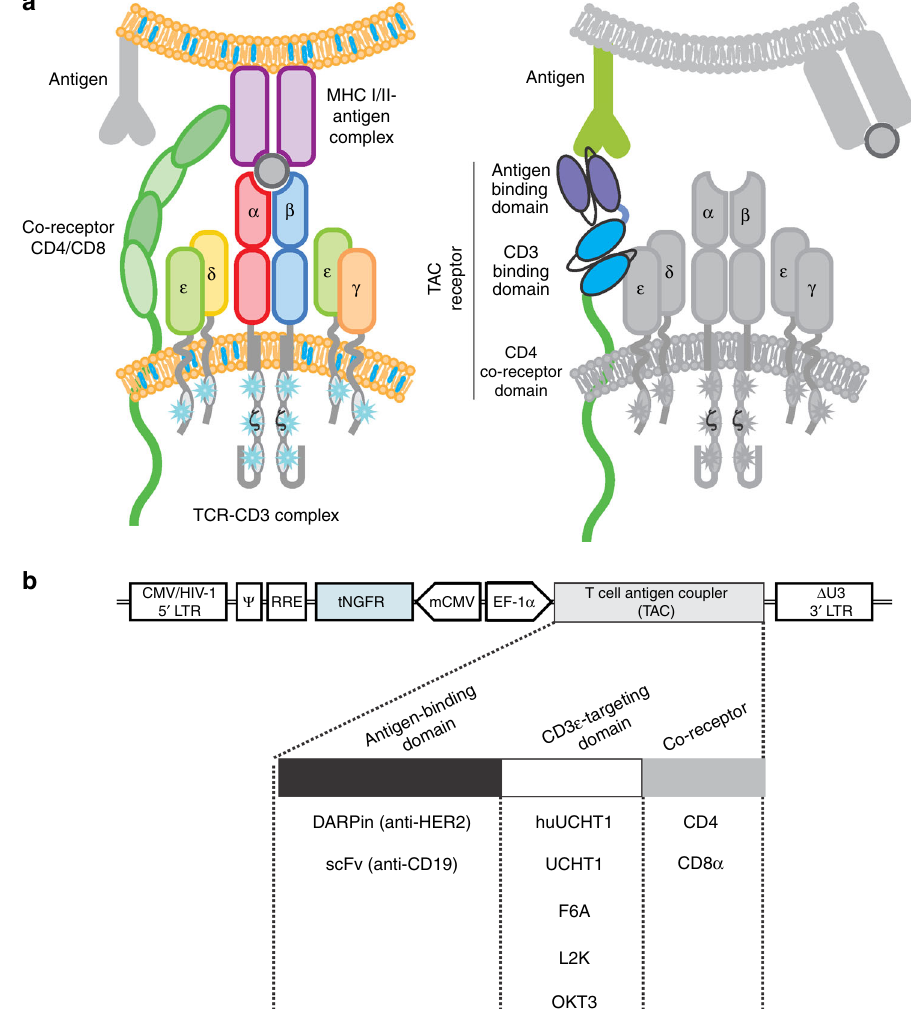
Fig. 1 TAC design mimics the TCR-CD3:co-receptor complex. a Left: Naturally occurring TCR-CD3 complex interacts directly with the antigen presented by MHC. Meanwhile, the CD8/CD4 co-receptor interacts with MHC I/II in an antigen-independent manner. Together, these interactions comprise the fi rst step in T cell activation. Right: The TAC receptor re-directs the TCR-CD3 complex towards an antigen of choice using an interchangeable antigen binding moiety (here depicted with an scFv, purple). An scFv is used to recruit the TCR-CD3 complex (blue). Co-receptor properties are incorporated by including the CD4 hinge, TM region, and cytosolic tail (green). b The TAC is incorporated into the pCCL DNA backbone containing a truncated NGFR (tNGFR), which lacks cytosolic signaling domains, as a transduction control. The vector features a bi-directional promoter system with tNGFR under control of the mCMV promoter and TAC expression being driven by the EF-1 α promoter. TAC is comprised of an antigen binding domain, a CD3-binding domain, and a co-receptor domain. A variety of proteins can be used for each of these three TAC domains allowing the TAC to be modi fi ed to best respond to numerous different antigens. The speci fi c domain combinations tested are described